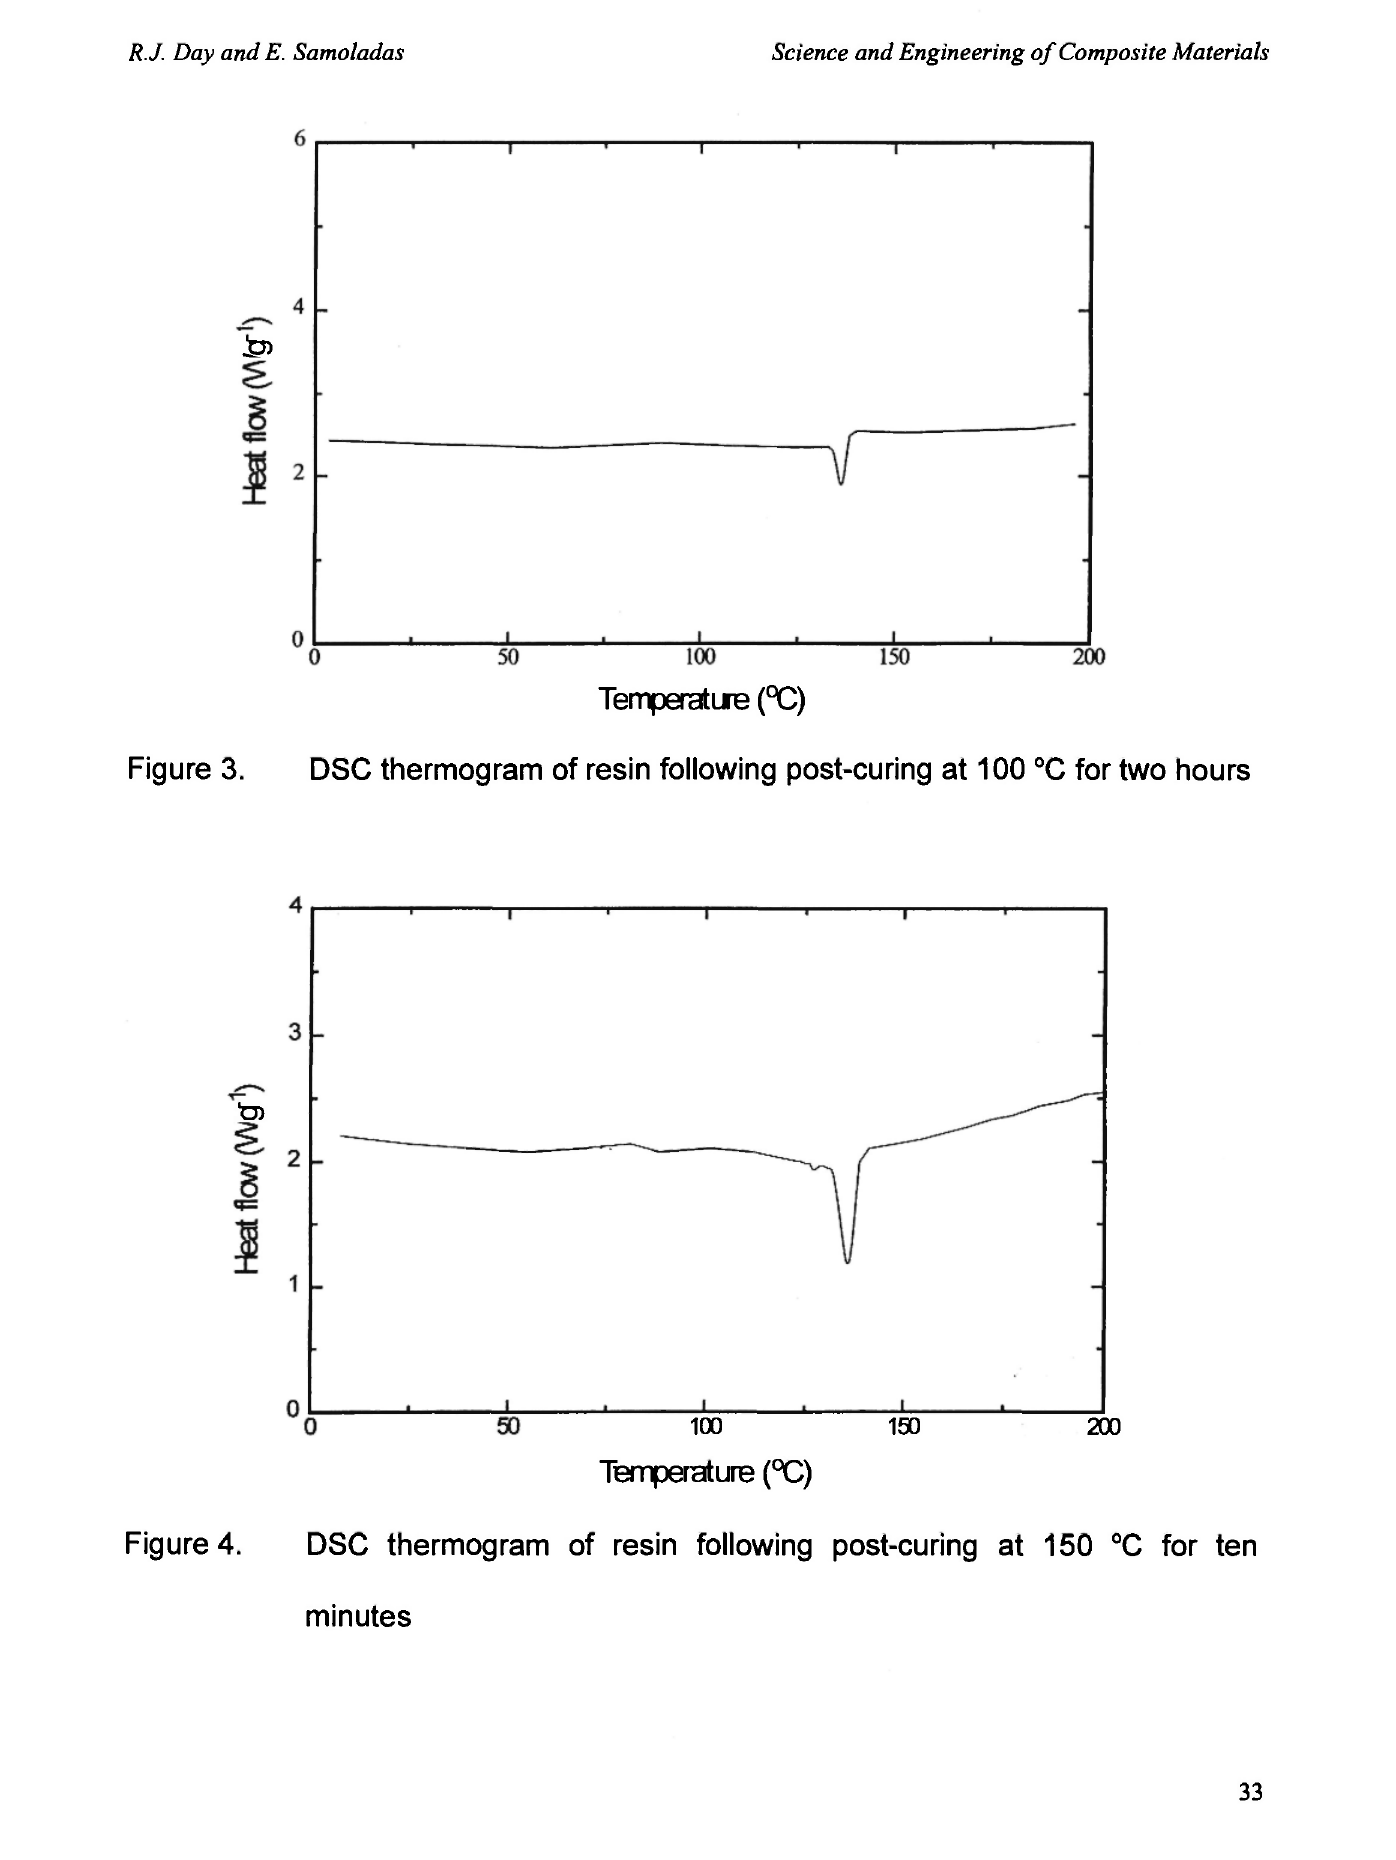
DSC thermogram of resin following post-curing at 150 °C for ten